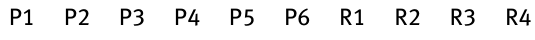
Table 4: A String for GA Optimization